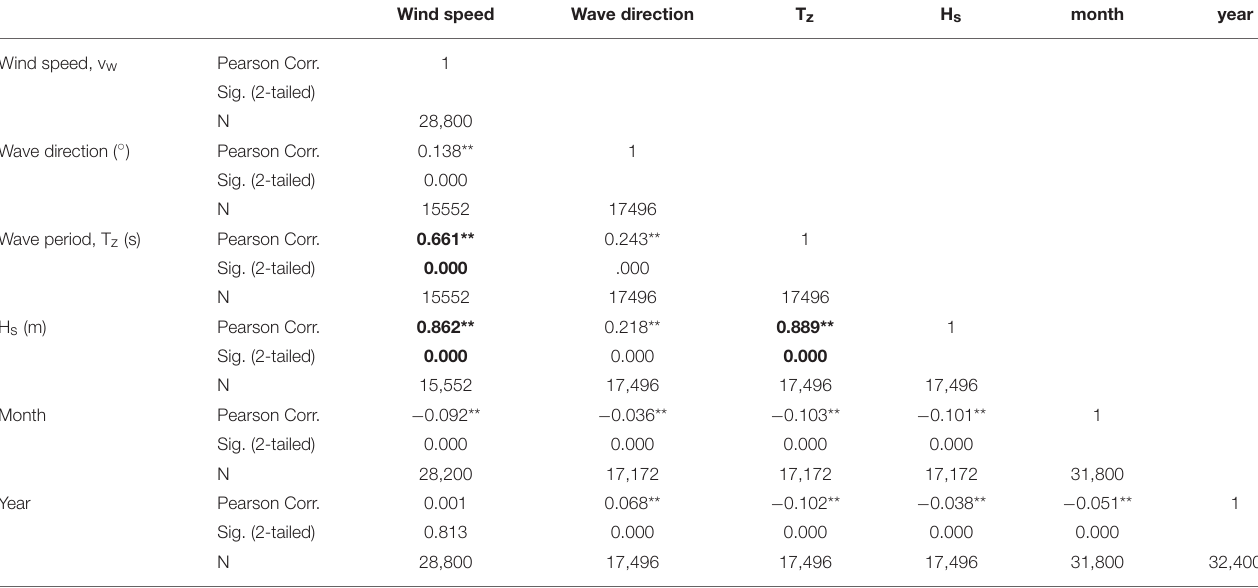
TABLE 2 | Correlations Matrix of wind speed (m/s), mean wave direction ( ◦ ), wave period T z (s) and significant wave height, H s (m), month and year.